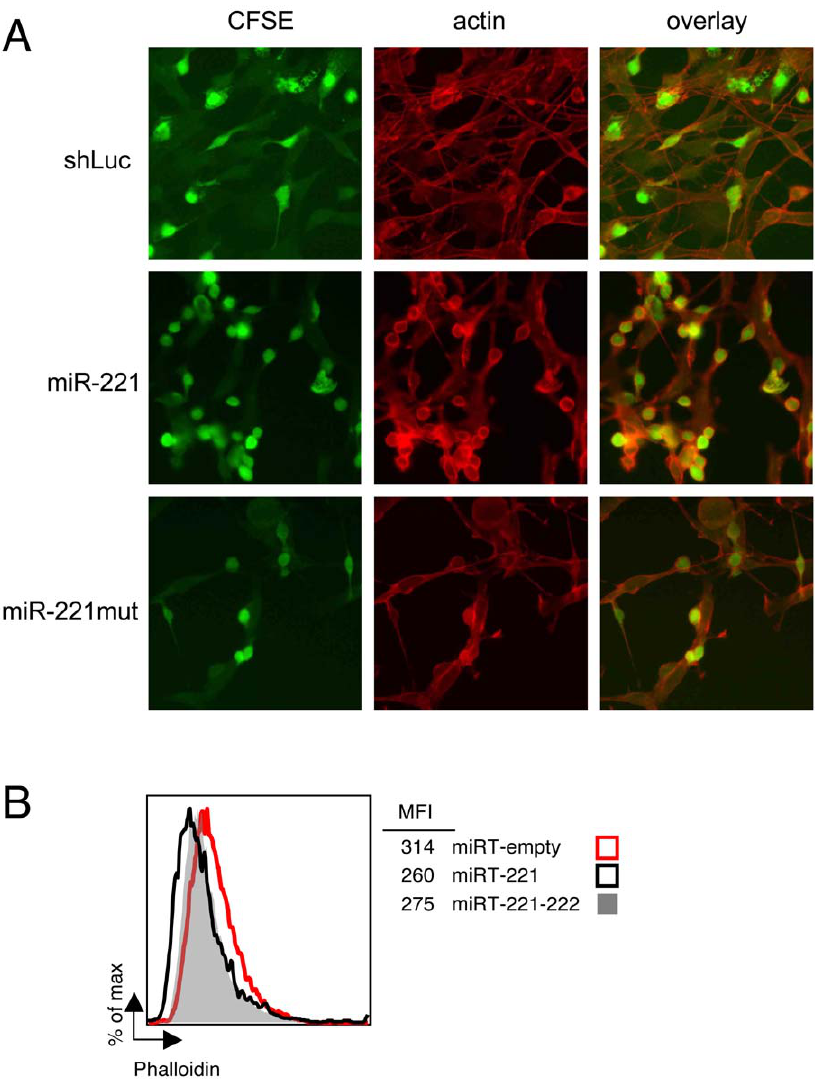
Figure 5. MiR-221 influences BMMCs actin cytoskeleton. A ) Transduced BMMCs were loaded with CFSE (green) and allowed to adhere to a monolayer of 3T3 cells. After washing to remove non-adherent cells, F-actin was stained with phalloidin-AlexaFluor-594 (red) prior imaging with a fluorescence microscope. Shown is one representative experiment out of three. B ) BMMCs were transduced with the indicated miRT vectors, and overall F-Actin content was assessed by FACS staining with phalloidin. Shown is one representative experiment out of